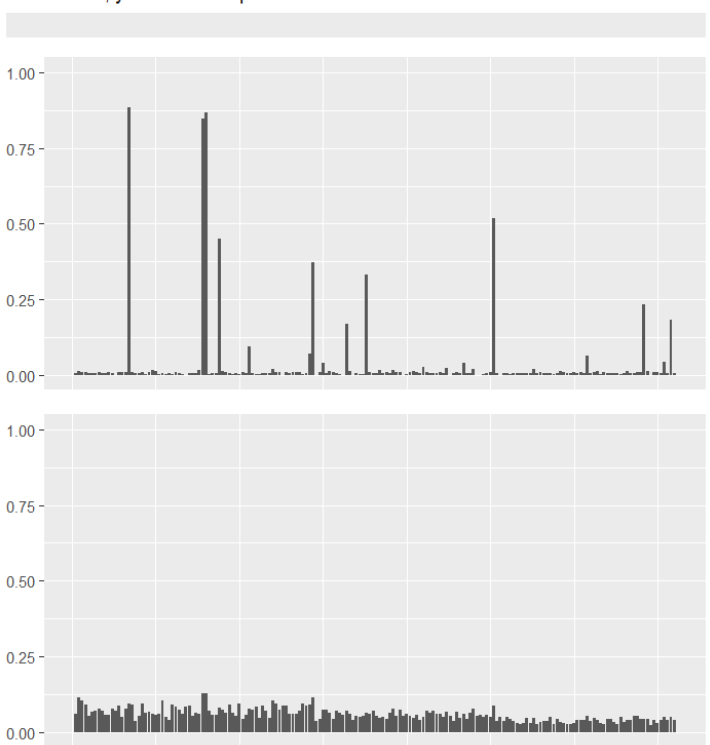
Figure 8. Item exposure comparison for the two fixed-precision CD-CAT implementations. GDI: general discrimination index; prog2: progressive method for item exposure control with b = 2.